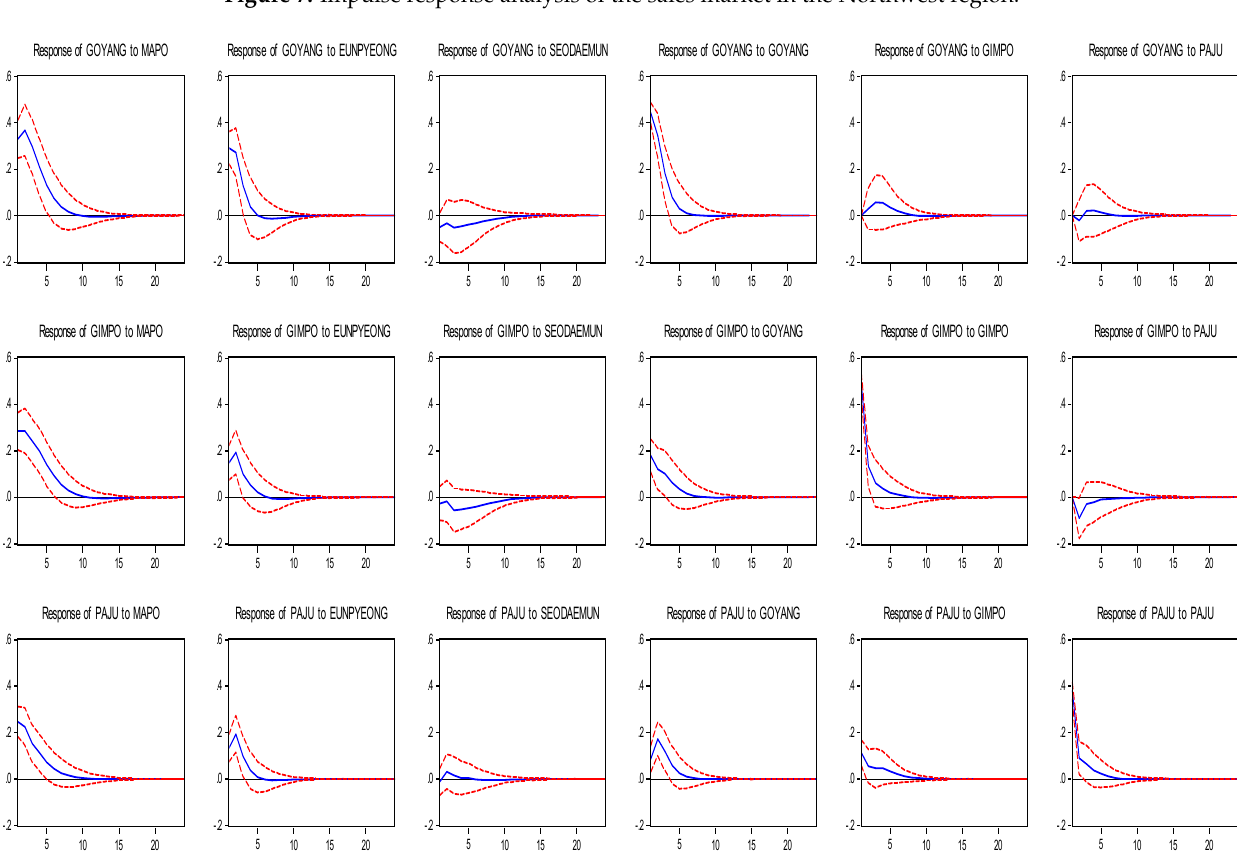
Figure 8. Impulse response analysis of the sales market in the Gyeongeui region. The results of the variance decomposition analysis indicate that the influence of in- dividual cities, especially the primary city, was more pronounced than that of jeonse price regarding the change in sales price. The contributions of Eunpyeong and Seodaemun to the change in the sales price in Mapo in the Northwest region were very low, amounting to less than 2%, and the contributions of cities in the Gyeongeui region were also very low, amounting to less than 1%. Moreover, the contributions of cities to the change in their own sales prices, excluding Mapo, decreased, while the contribution of the primary city (Mapo) to changes in the sales prices in all cities gradually increased. This indicates that the change in jeonse price has a mutual interaction between neigh- boring cities, but the sales price is transferred in one direction. In other words, price spill- over in the city with the highest sale price (Mapo) affects the neighboring cities (Eun- pyeong, Seodaemun), and this effect goes on to affect Goyang, the primary city of the Gyeongeui region that is subordinate to the Northwest region. Further, this effect, in turn, affects other cities in the Gyeongeui region as well. However, the opposite price effect was found to be negligible, indicating that the unilateral spillover of the sales price is very strong compared to that of the jeonse price (see Figures 9 and 10).